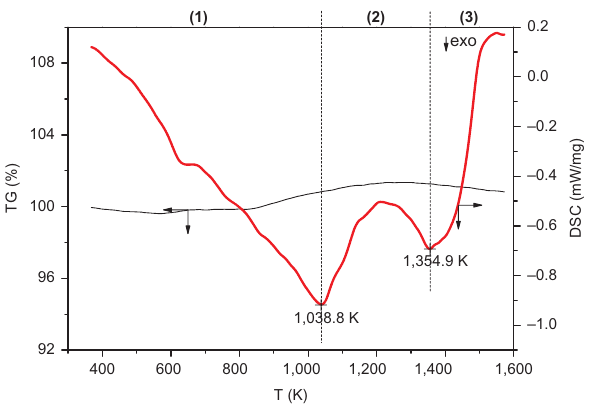
Figure 5: Effect of roasting temperature on the CS of HCVTM